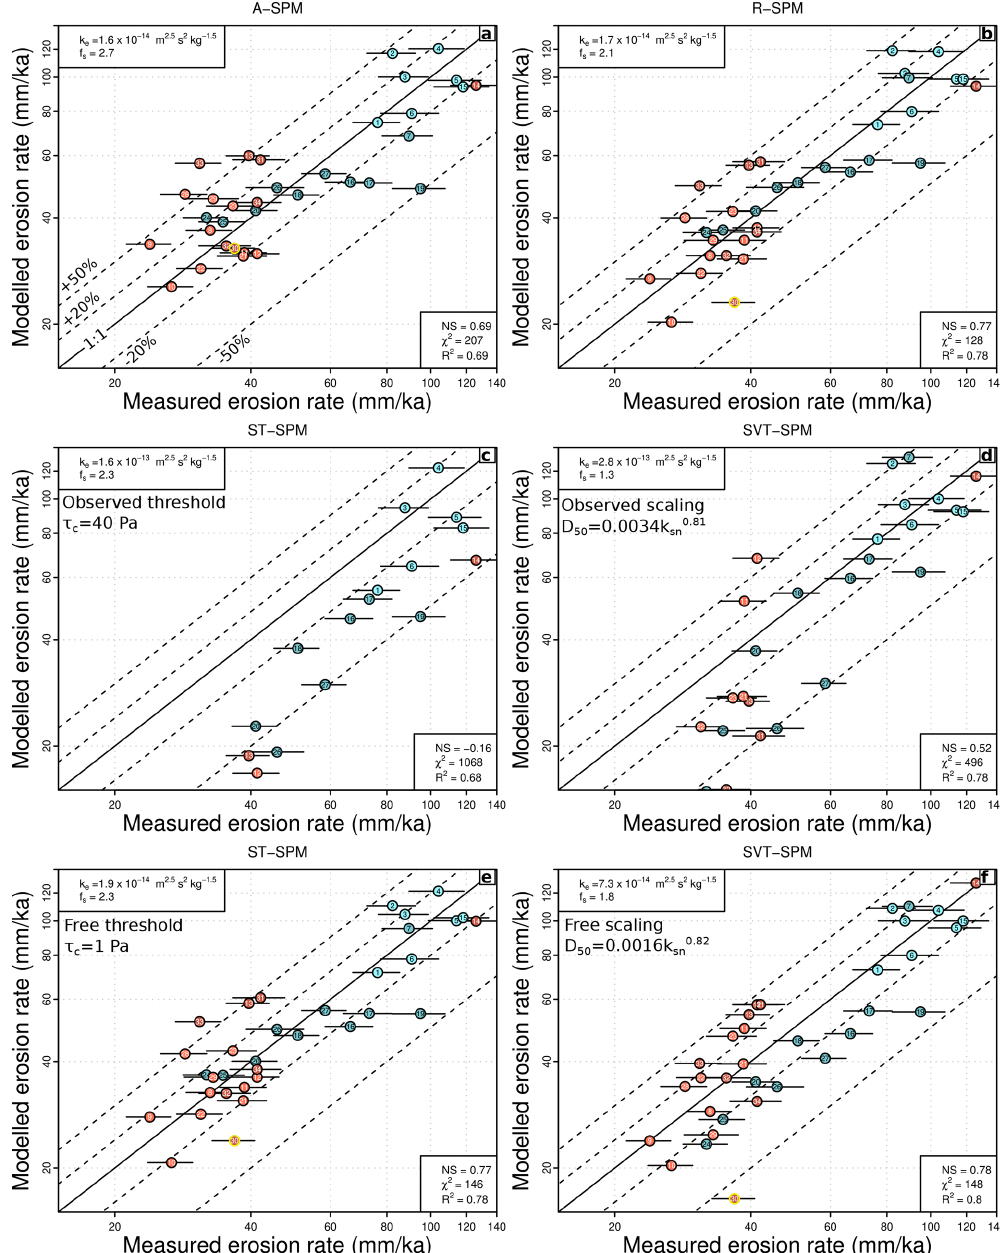
Figure 7. Comparison between measured and modeled denudation rates for various formulations of the stream power model. Black lines correspond to a perfect match between observed and modeled denudation rates, and dashed lines indicate ± 20% and ± 50% deviations. Basin 30, with a much smaller area than the rest of the dataset, is outlined in yellow. (a) Area-based stream power model (A-SPM). The erodibility coefficient k e and modulation factor for Cévennes schists f s are free parameters. (b) Runoff-based stream power model (R-SPM). (c) Stochastic stream power model with an imposed spatially constant threshold τ c (ST-SPM) defined using the mean regional average D 50 value (Eq. 3 and Fig. 5b). (d) Stochastic stream power model, with a spatially variable threshold (SVT-SPM), scaled with k sn values (Eqs. 13 and 3). The scaling parameters are set according to the observed relationship between D 50 and k sn values in Fig. 5b. (e) Stochastic stream power model (same as c ), but with τ c as a free parameter (in addition to k e and f s ). (f) Stochastic stream power model, with a spatially variable threshold (SVT-SPM, same as d ) but with the scaling parameters k 50 and q from Eq. (13) being free (in addition to k e and f s ).